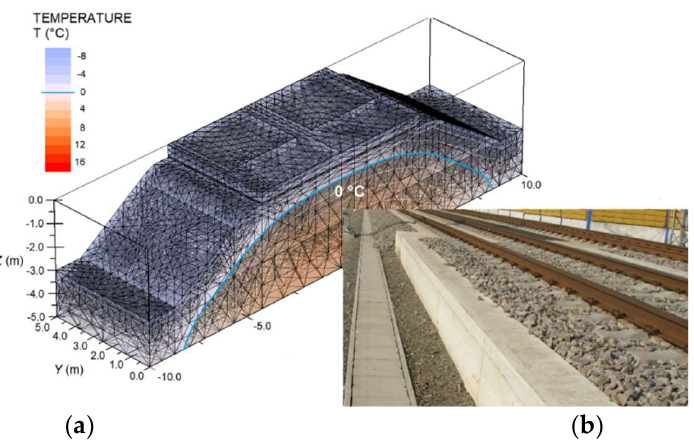
Figure 1. Reinforced-concrete transition zones in Trencianske Bohuslavice: ( a ) numerical model [7]; ( b ) photo [Hodas]—built into track.